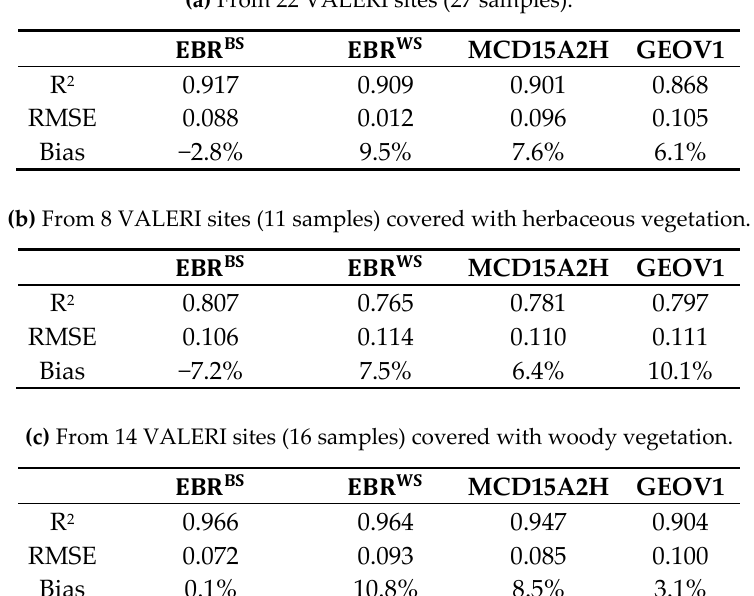
Figure 10. Validation of the EBR black-sky FAPAR (EBR BS ), MCD15A2H, and GEOV1 FAPAR products using reference FAPAR estimates from 22 VALERI sites. Table 6. Accuracy of the FAPAR products using reference FAPAR